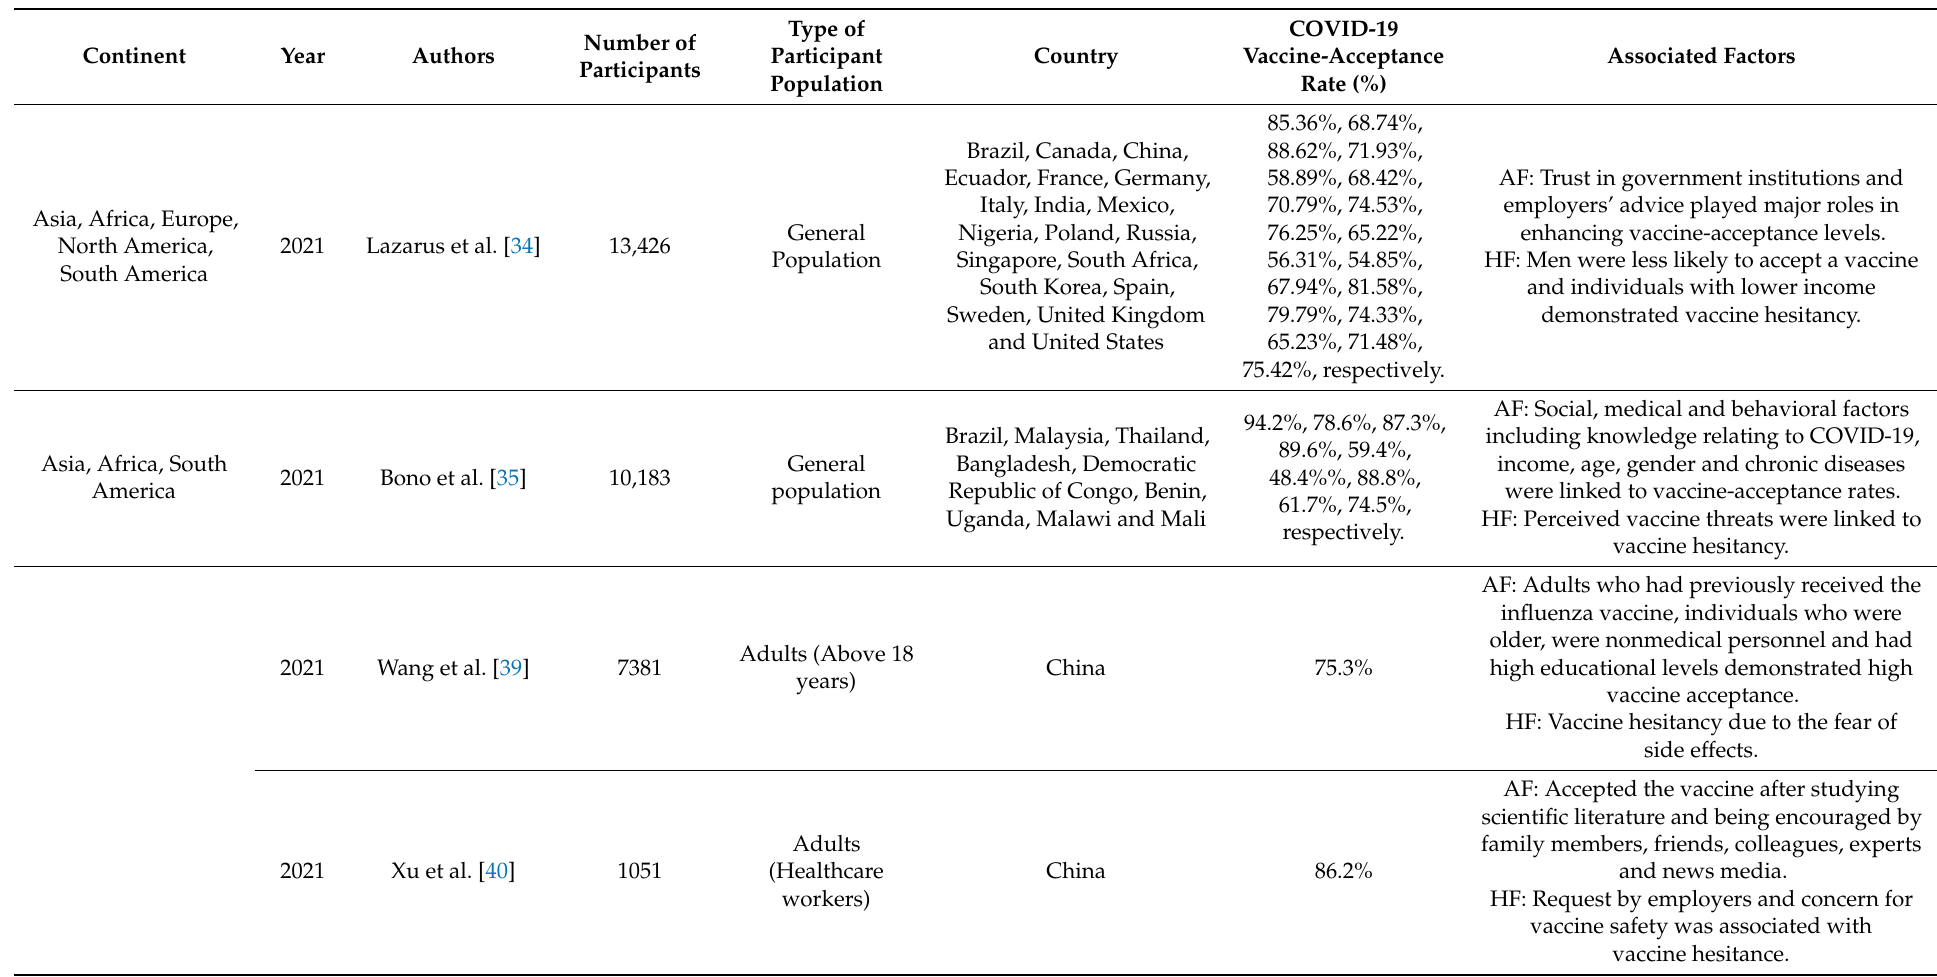
Table 1. Summary of the studies included in the systematic review based on the vaccine-acceptance rates and their associated social and behavioral factors. AF: acceptance factors; HF: hesitancy factors; HCWs: healthcare